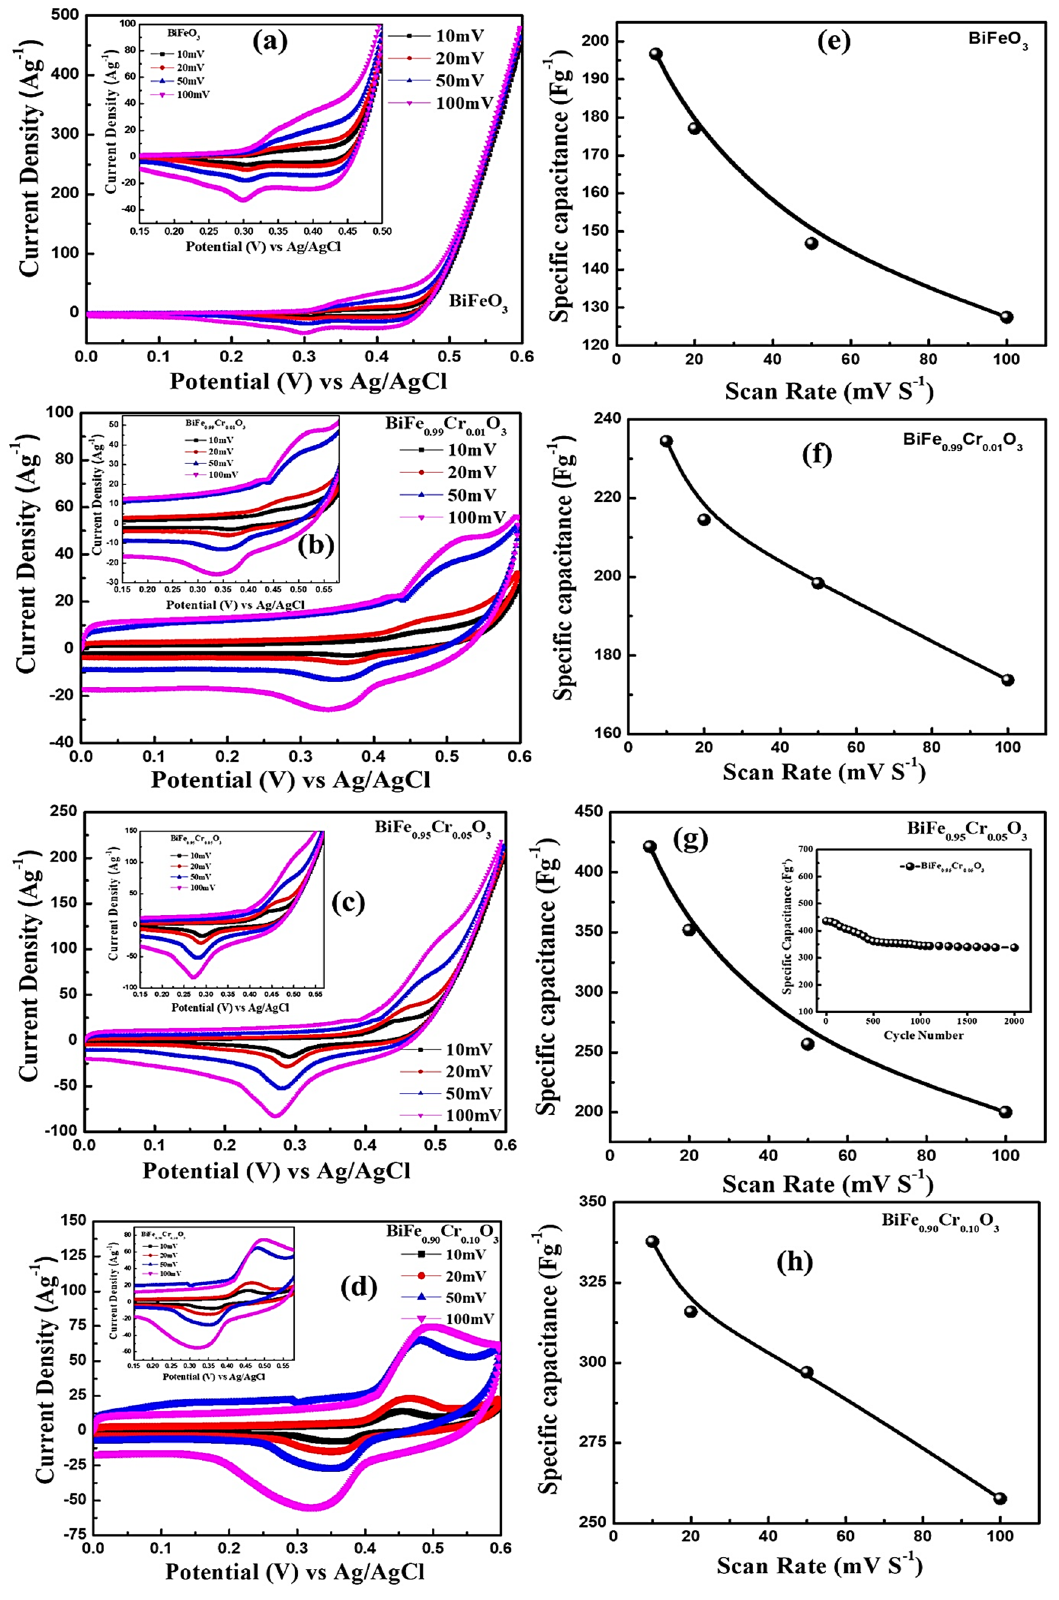
Figure 10. ( a – d ) CV plots of BiFe 1 − x Cr x O 3 (0 ≤ x ≤ 10) nanoparticles with different scan rates. ( e – h ) Variation in the specific capacitance of the BiFe 1 − x Cr x O 3 (0 ≤ x ≤ 10) nanoparticles electrode with different scan rates.